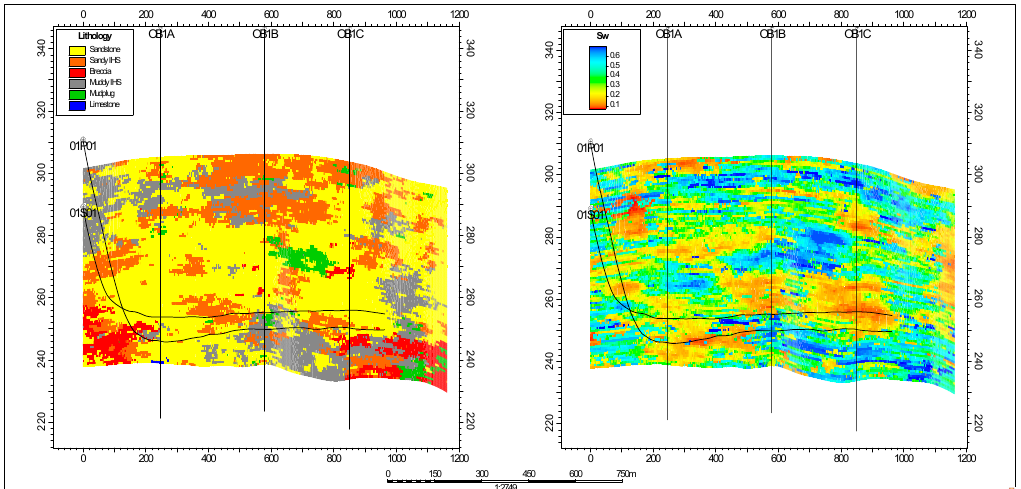
Figure 11. Cross-sectional map of lithology and water saturation along the horizontal well pair 1.